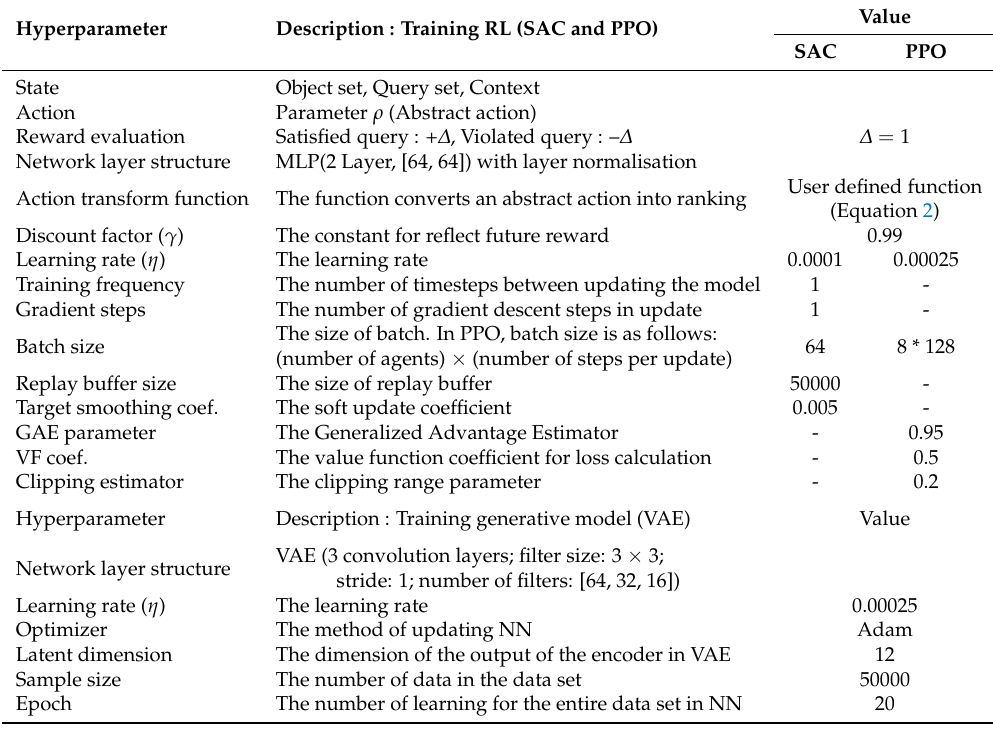
Table 2. Hyperparameter description and value setting for